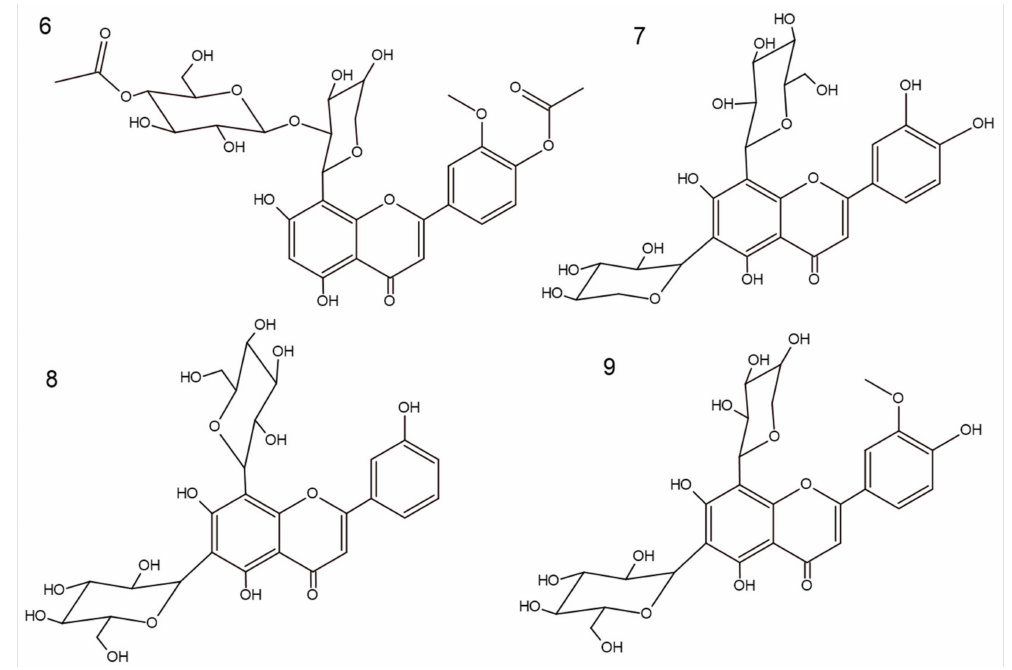
Figure 1. Chemical structures of compounds 6 – 9